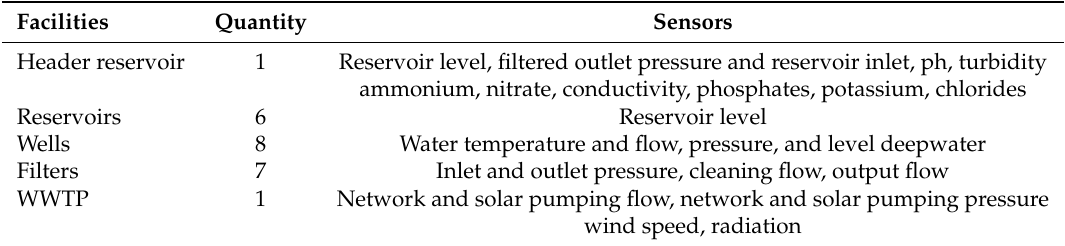
Table 1. Type of facilities from supervisory control and data acquisition (SCADA) that are integrated into the platform and the associated